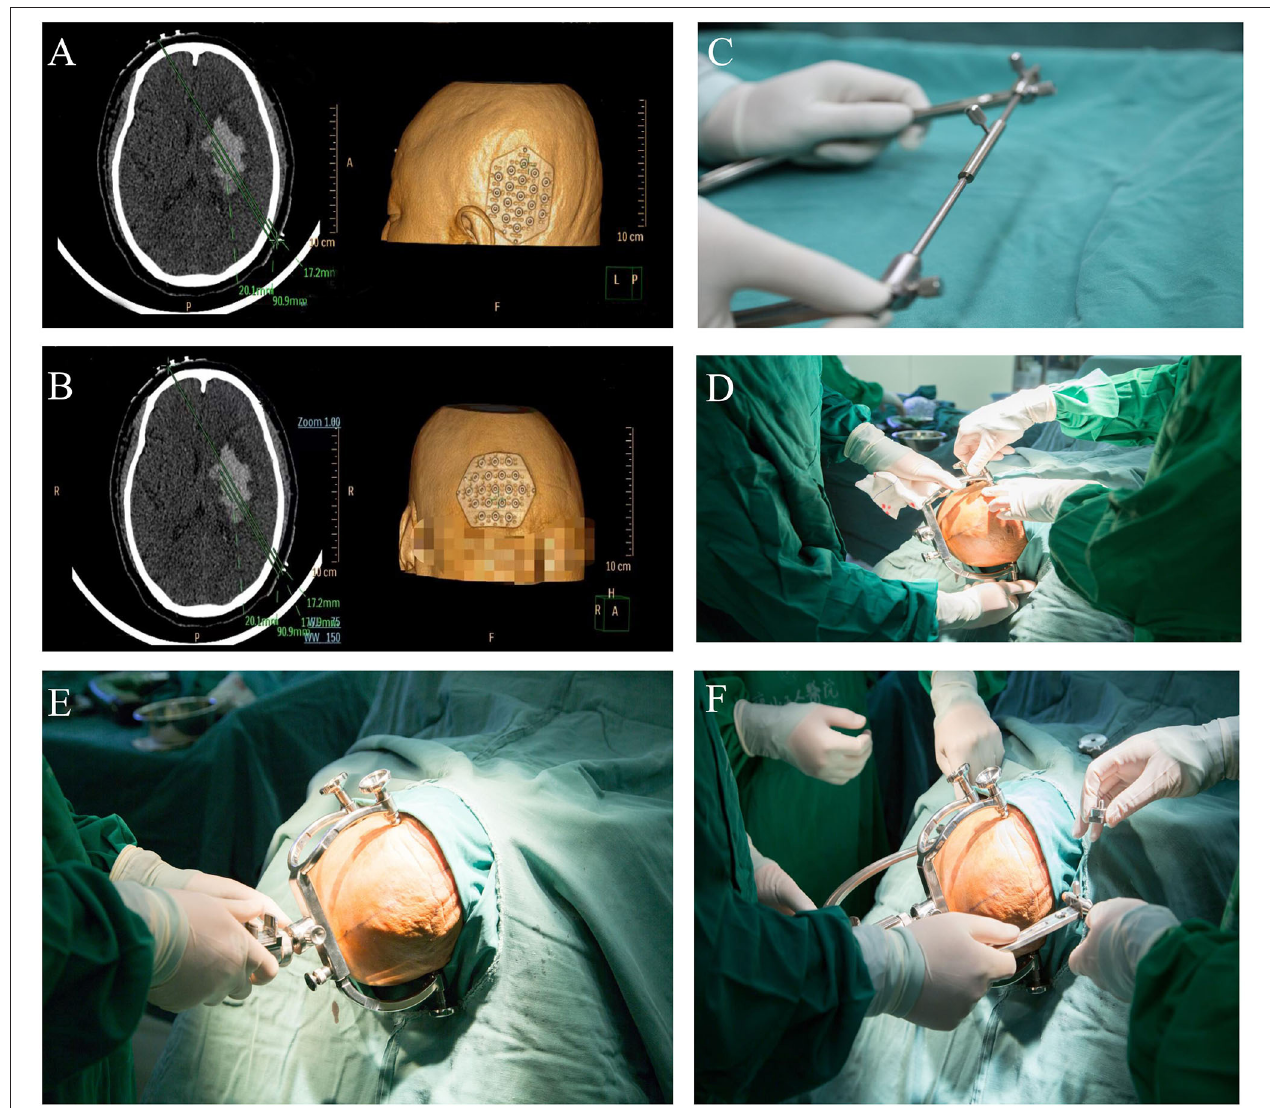
FIGURE 3 | (A,B) show that the accurate puncture site, reference point, puncture route, puncture depth, and drill depth are located on the skin by performing a CT scan with 1mm for each layer using the PISP (Philips IntelliSearch Portal v5.0.2.10010) system. The brain surgery head frame is correct in (C) , and (D–F) is the fixation process of the head